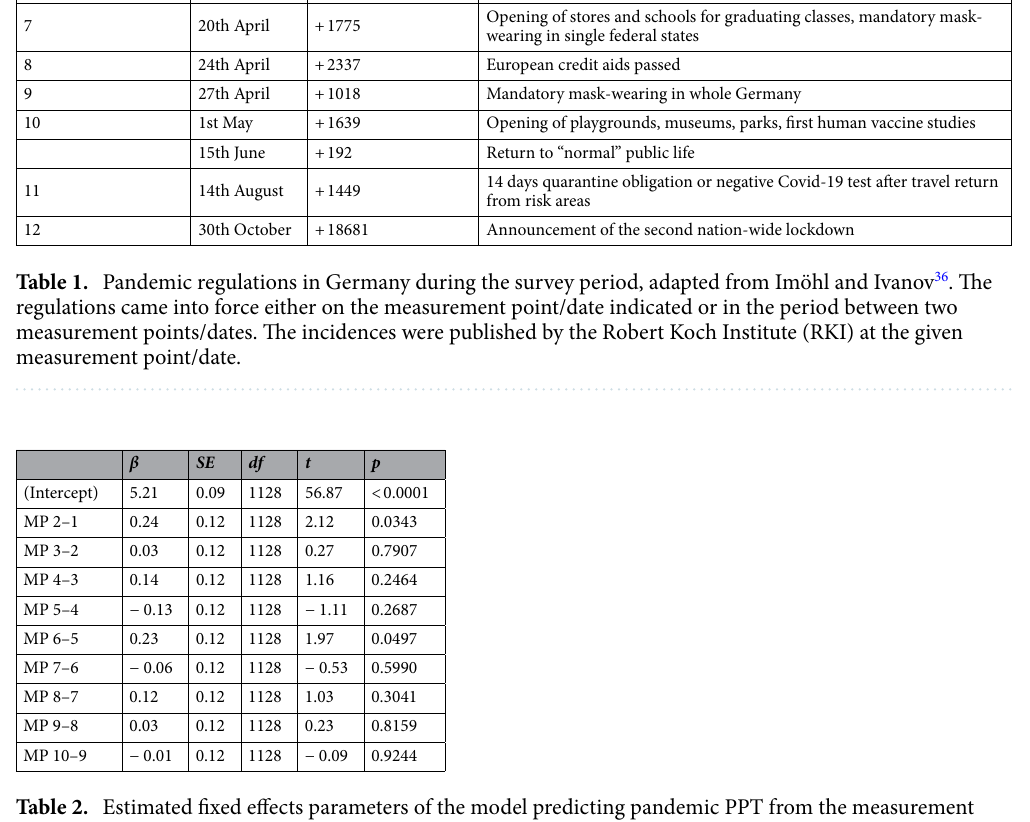
Table 2. Estimated fixed effects parameters of the model predicting pandemic PPT from the measurement point (MP). Shown are effect estimates ( β ), standard errors (SE), degrees of freedom (df), t and p values. The difference coding compares the means of two consecutive measurement